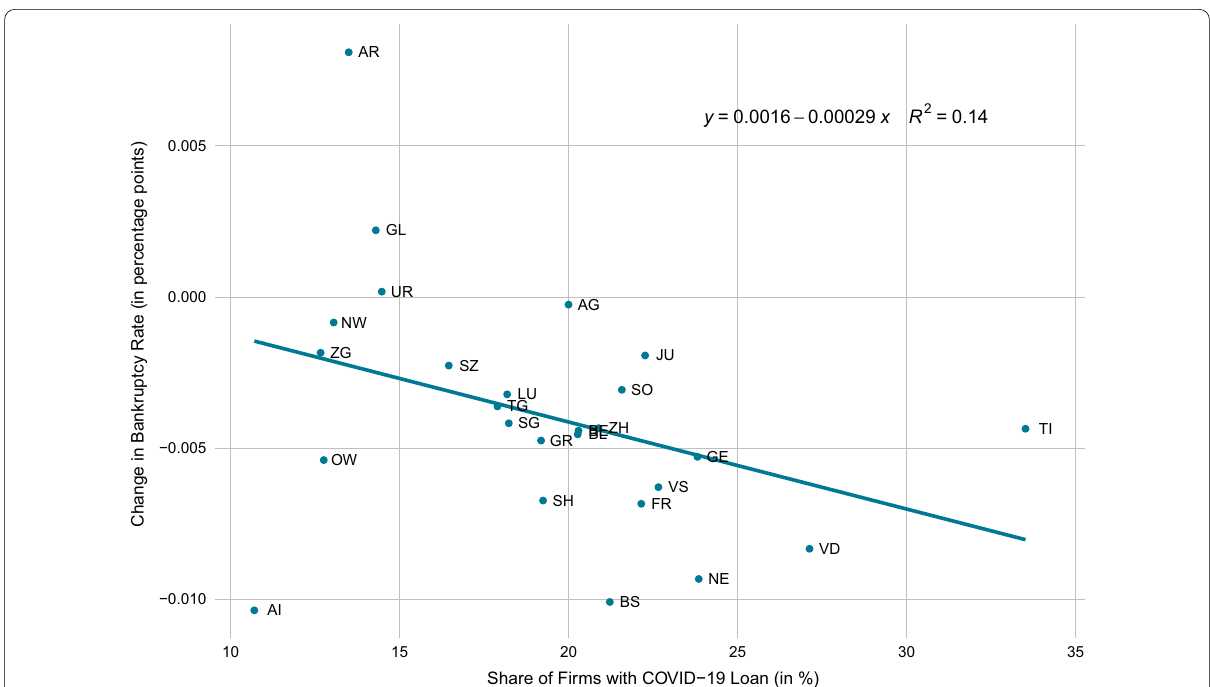
Fig. 11 Relationship of COVID-19 loans and bankruptcies across cantons. Notes : The scatter plot shows the correlation between the share of firms who took out COVID-19 loans and the change in bankruptcy rates across cantons. The change in bankruptcy rates is given by the difference in average bankruptcy rates 22 months before and after the start of the COVID-19 crisis. The results are robust to choosing a 12-month or 18-month comparison window. Abbreviations: Aargau (AG), Appenzell Ausserrhoden (AR), Appenzell Innerrhoden (AI), Basel-Landschaft (BL), Basel-Stadt (BS), Bern (BE), Fribourg (FR), Genève (GE), Glarus (GL), Graubünden (GR), Jura (JU), Luzern (LU), Neuchâtel (NE), Nidwalden (NW), Obwalden (OW), Schaffhausen (SH), Schwyz (SZ), Solothurn (SO), St. Gallen (SG), Thurgau (TG), Ticino (TI), Uri (UR), Valais (VS), Vaud (VD), Zug (ZG) and Zürich